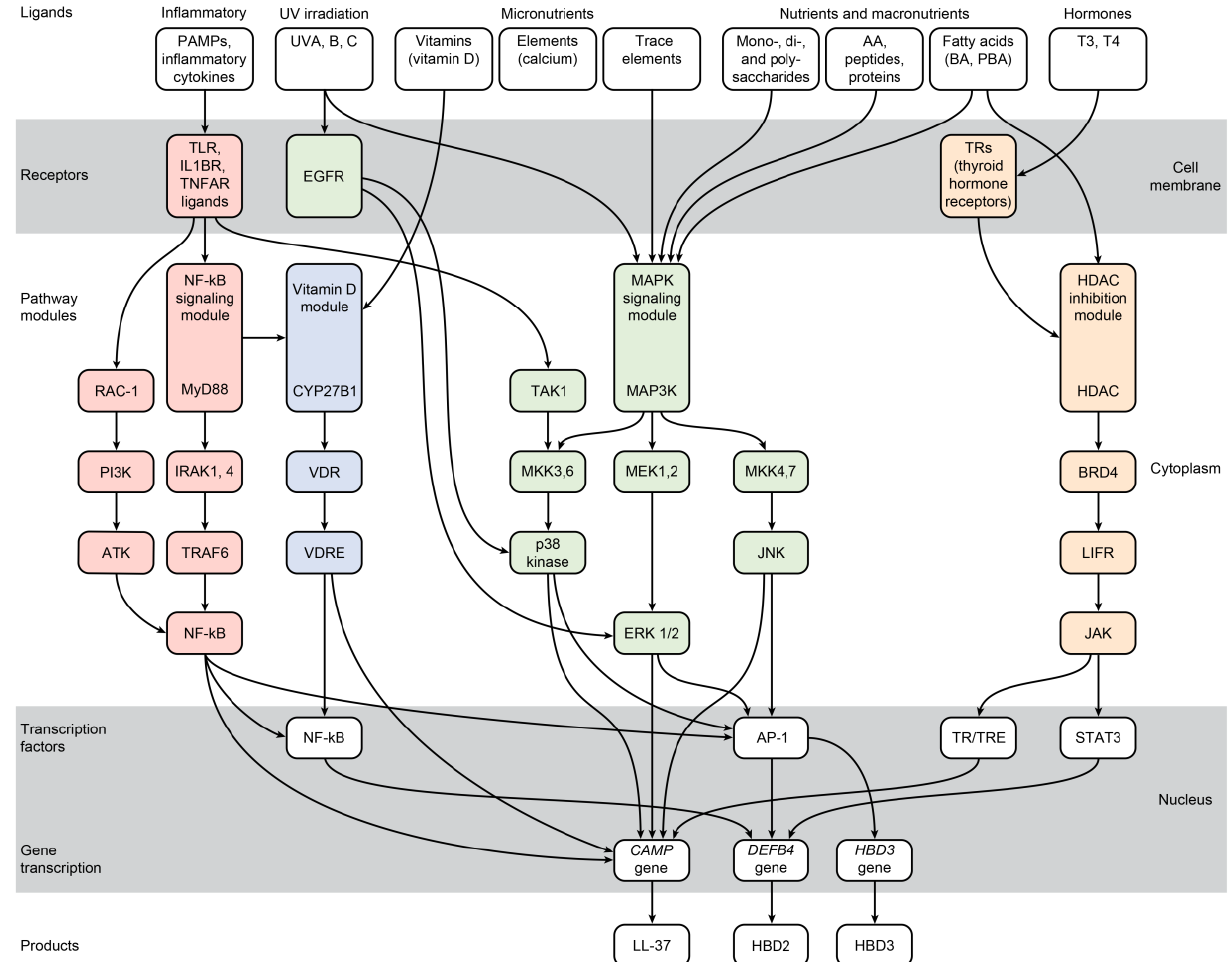
Figure 1. A generalized scheme showing the pathways for the induction of AMP transcription and expression via nutritional, hormonal, and physical stimuli through the MAPK signaling, vitamin D signaling, HDAC inhibition signaling, NF-kB signaling, and TR/RXT signaling modules. All signaling cascades converge onto a few transcription factors (TF) that bind to TF-specific motifs and response elements in the promoter regions of the respective AMP genes. Detailed information on each of these signaling pathways is included in Supplemental Figures S1 – S4.